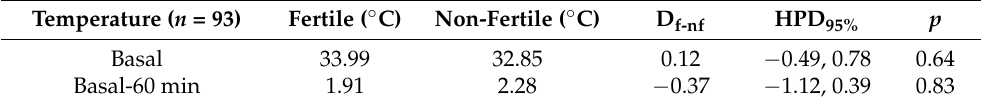
Table 4. Effect of fertility on basal temperature and temperature range between basal and 60 min. Temperature ( n = 93) Fertile ( ◦ C) Non-Fertile ( ◦ C) D f-nf HPD 95% p Basal 33.99 32.85 0.12 − 0.49, 0.78 0.64 Basal-60 min 1.91 2.28 − 0.37 − 1.12, 0.39